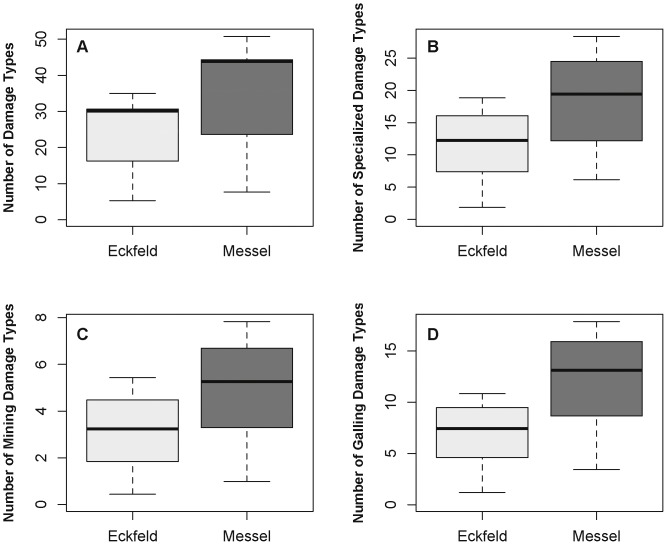
Mean diversity of damage types (DTs) on the bulk floras rarified to 800 leaves.A. Mean diversity of damage types (DTs) on the bulk floras. B. Specialized DTs. C. Mining DTs. D. Galling DTs. The horizontal line is the median, the top and bottom horizontal margins of the box are respectively the upper and lower quartiles, and the vertical lines are the full range of values from the data.